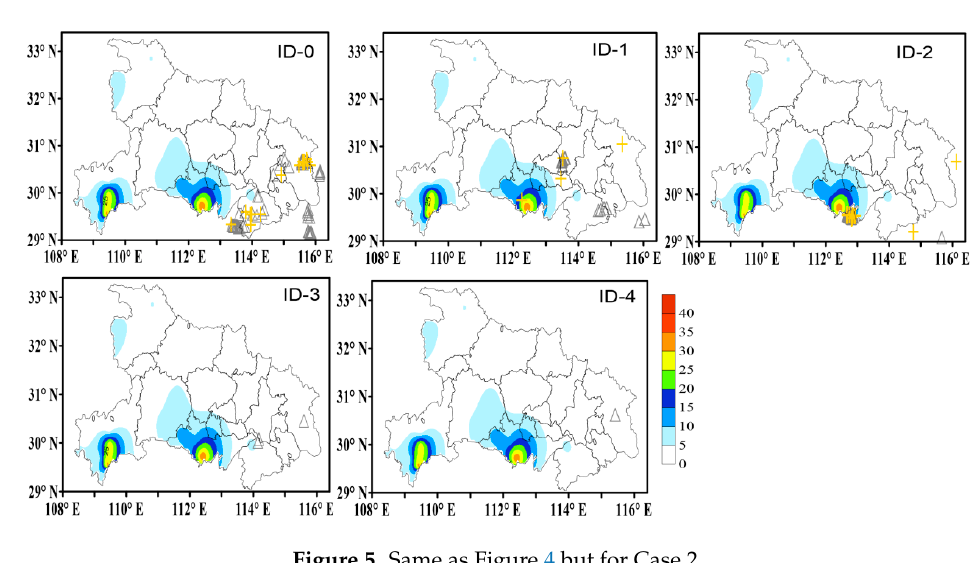
Figure 4. The spatial distribution of CG flashes produced by 14 thunderstorm cells and hourly precipitation (color contours, unit: mm) in Case 1 (grey triangle: 1 ≤ N -CG ≤ 100; red triangle: 100 < * Time window is taken from the red dotted box section of Figure 2. N -CG ; yellow plus: 1 ≤ N +CG ≤ 10; green plus: N +CG > 10, unit: flashes per 6 min).